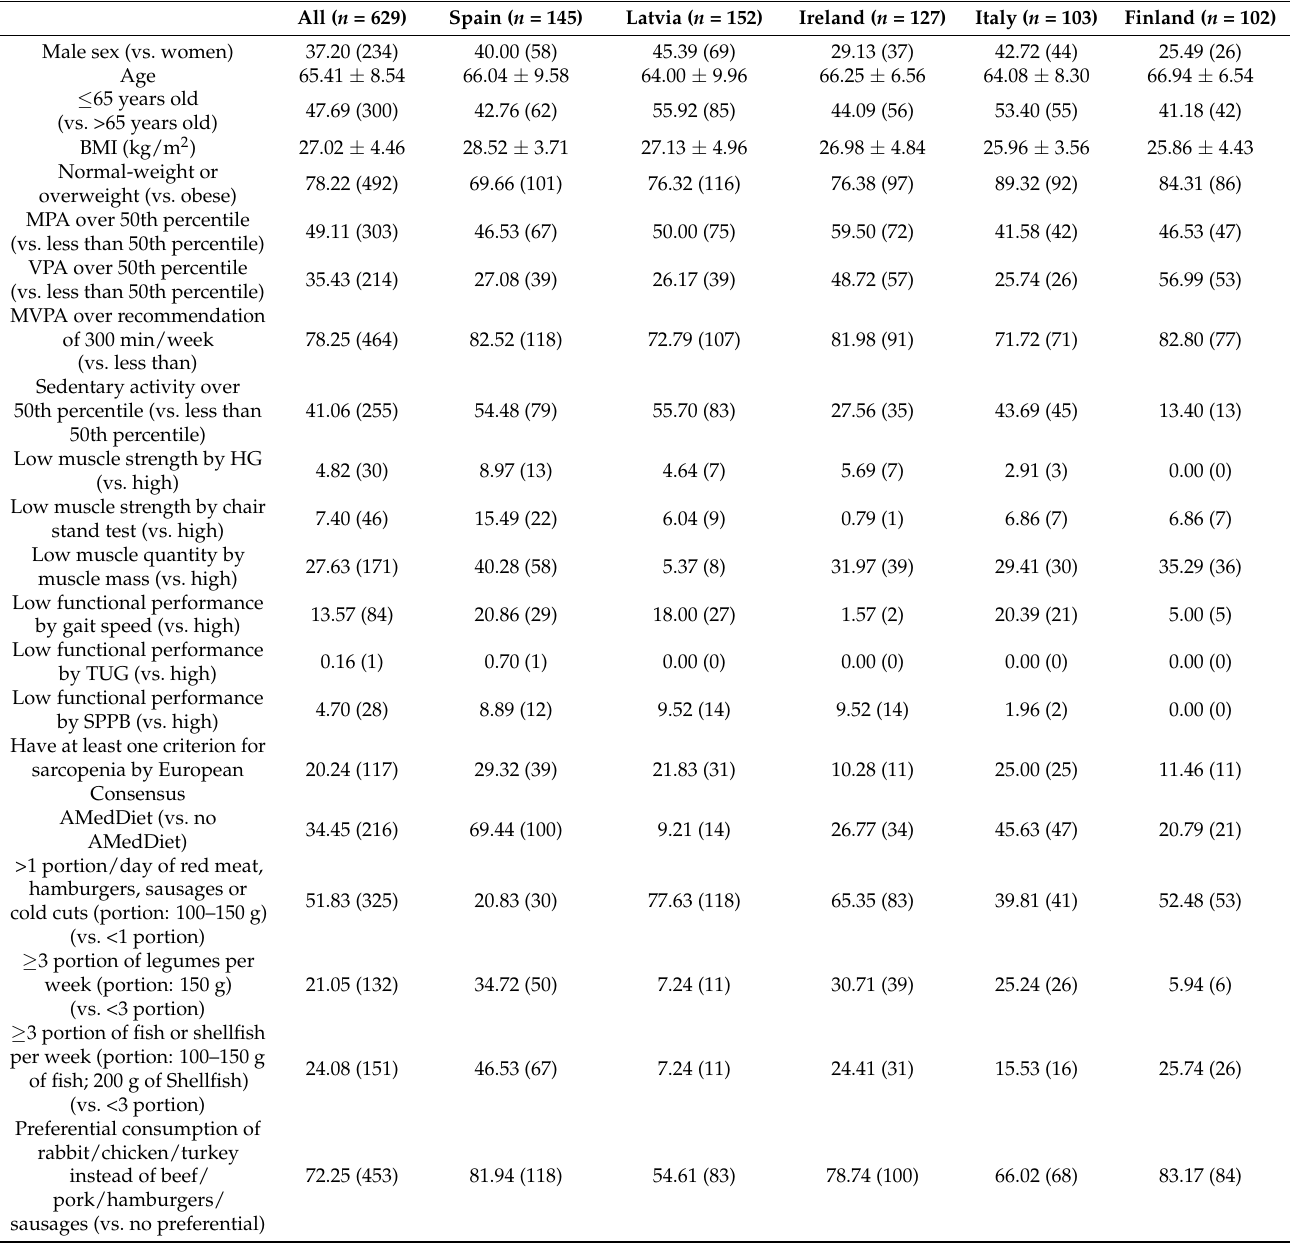
Table 1. Characteristic of European middle and older adults, overall and by country [%( n )—X ± SD]. All ( n = 629) Spain ( n = 145) Latvia ( n = 152) Ireland ( n = 127) Italy ( n = 103) Finland ( n = 102) Male sex (vs.